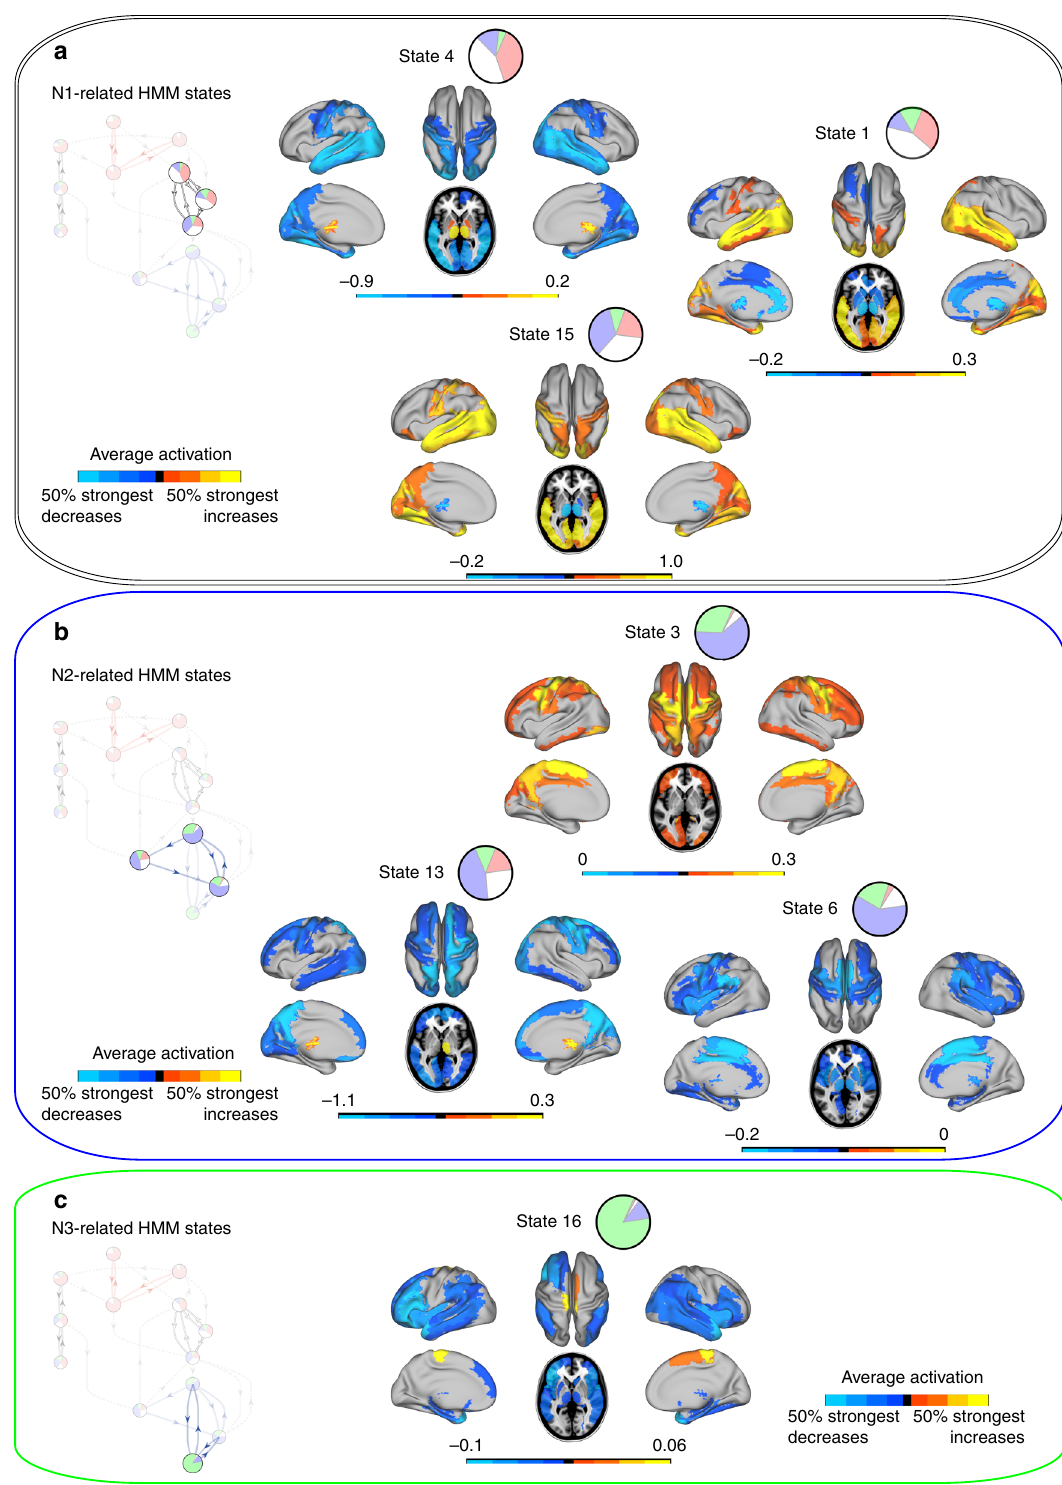
Fig. 6 Mean activation distributions of sleep-related HMM states. a HMM states associated with N1 sleep showed opposite signs in mean activation in subcortical areas and primary sensory areas of the cortex. b Three HMM states related to N2 sleep. HMM states 3 and 6 in particular showed peak increases and decreases, respectively, in areas previously identi fi ed as fMRI-correlates of sleep spindles. c HMM state 16 is dominating slow wave sleep (N3). Interestingly, there are marked decreases in mean activation in frontal areas and insula, and very localised increases in the supplementary motor area and paracentral lobule. All maps were thresholded above the 50% strongest positive and negative changes,